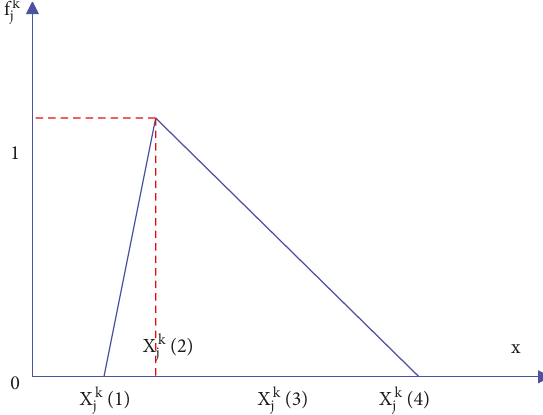
Figure 6: Schematic diagram of moderate measure